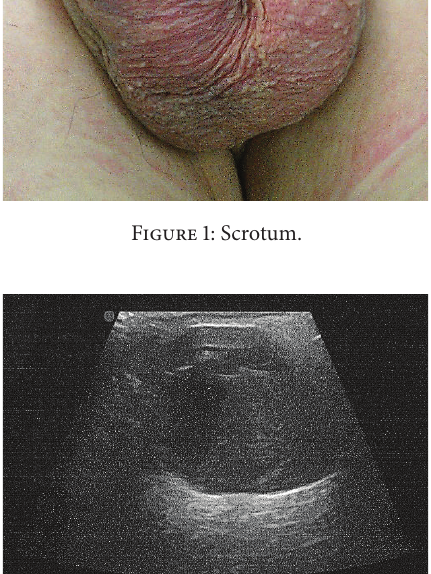
Figure 3: MRI showing prosthesis with linguini sign (free-floating loose thread).